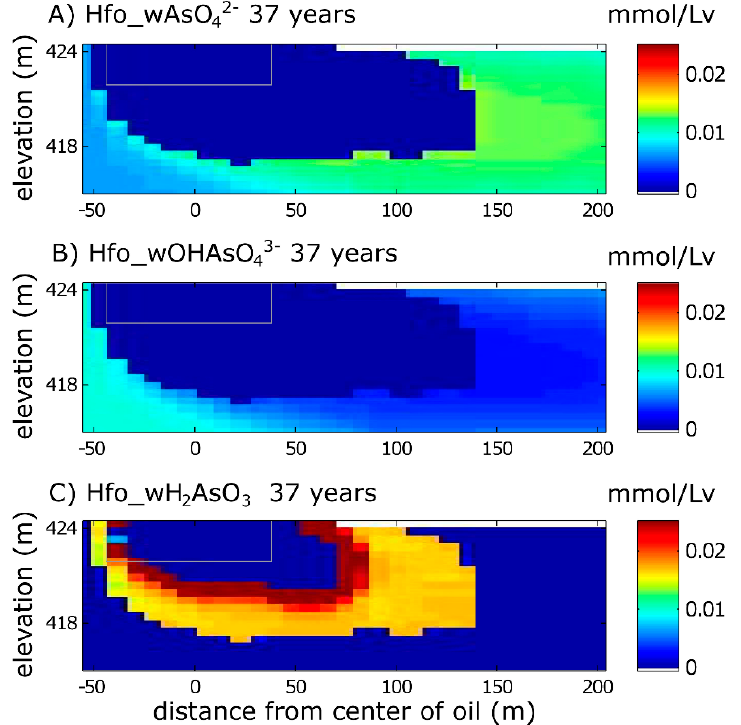
Figure 5. Model simulation results for As(V) and As(III) species sorbed to Fe(OH) 3 in 2016 (37 years after the oil spill). ( A ) Hfo_wAsO 42 − and ( B ) Hfo_wOHAsO 43 − are As(V) species; ( C ) Hfo_wH 2 AsO 3 is an As(III) species. Hfo_wH 2 AsO 4 , Hfo_wHAsO 4 − are not shown because they do not participate in As cycling under the conditions of this site. The gray box is the reference for the extent of the oil body. The top boundary is the water table.